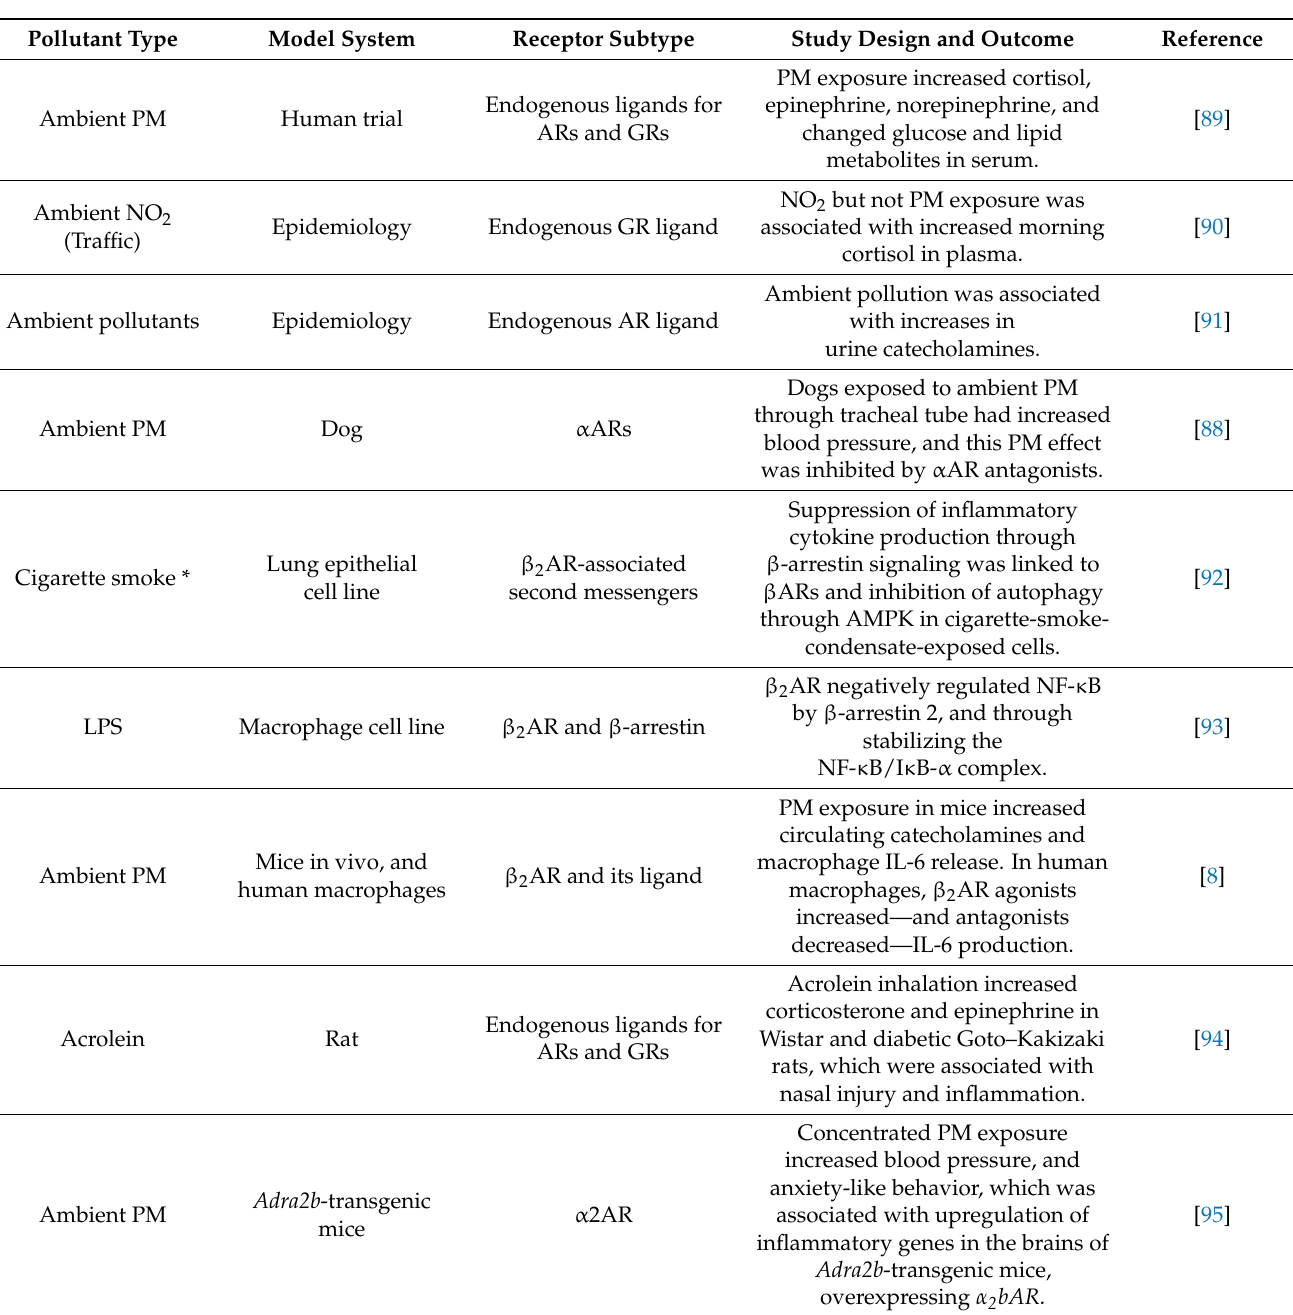
Table 2. Selected respirable particulate matter (PM) and acrolein studies incorporating the roles of adrenergic receptors (ARs) and glucocorticoid receptors (GRs) and/or their endogenous ligands—catecholamines and glucocorticoids, respectively. Only the data pertaining to ARs and GRs are summarized in the table. * There are a number of cigarette smoke and other studies that have implicated the contribution of ARs and GRs to observed health effects, but only one example is provided. LPS: lipopolysaccharides; PM: respirable particulate matter; NF- κ B: nuclear factor kappa B; IL-6: interleukin 6; NO 2 : nitrogen